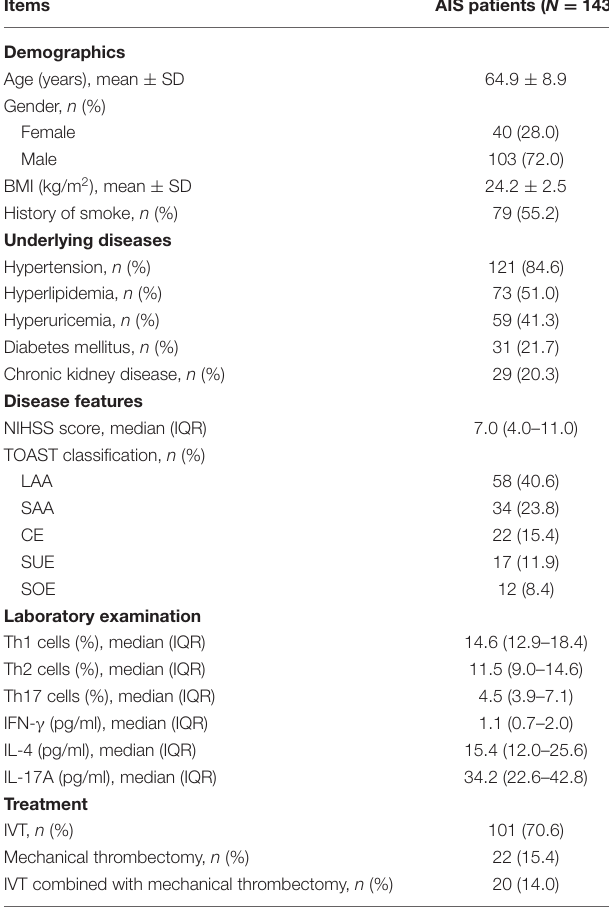
TABLE 1 | Characteristics of AIS